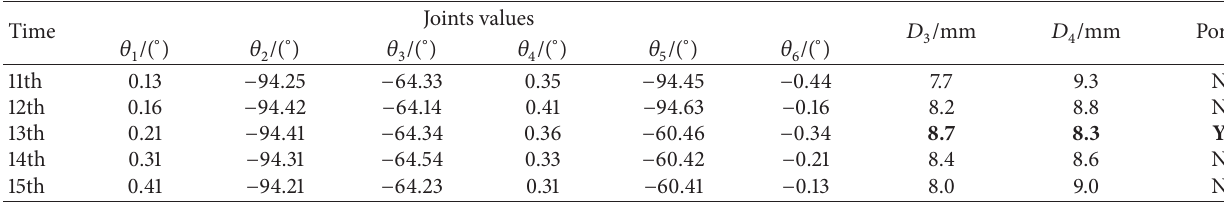
Table 2: The results of the warning